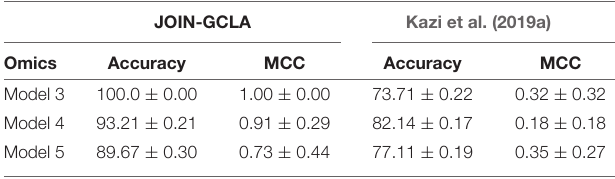
TABLE 7 | Comparison between JOIN-GCLA with alternative fusion